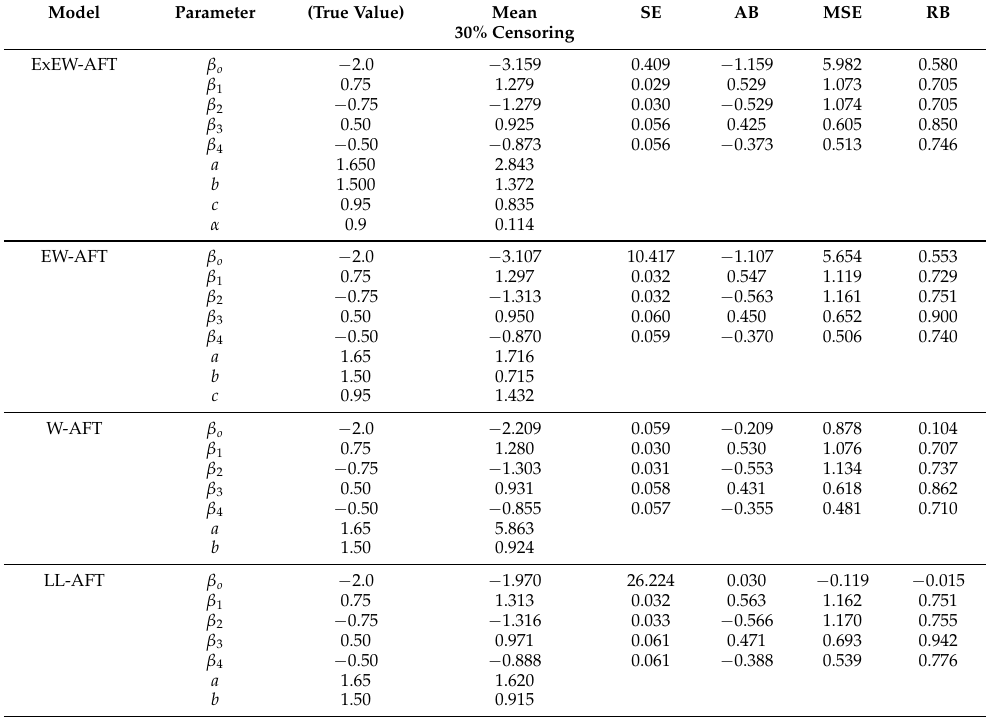
Table 16. Simulation study for scenario 4 ( n = 5000) with about 30% censored observations is used to compare model